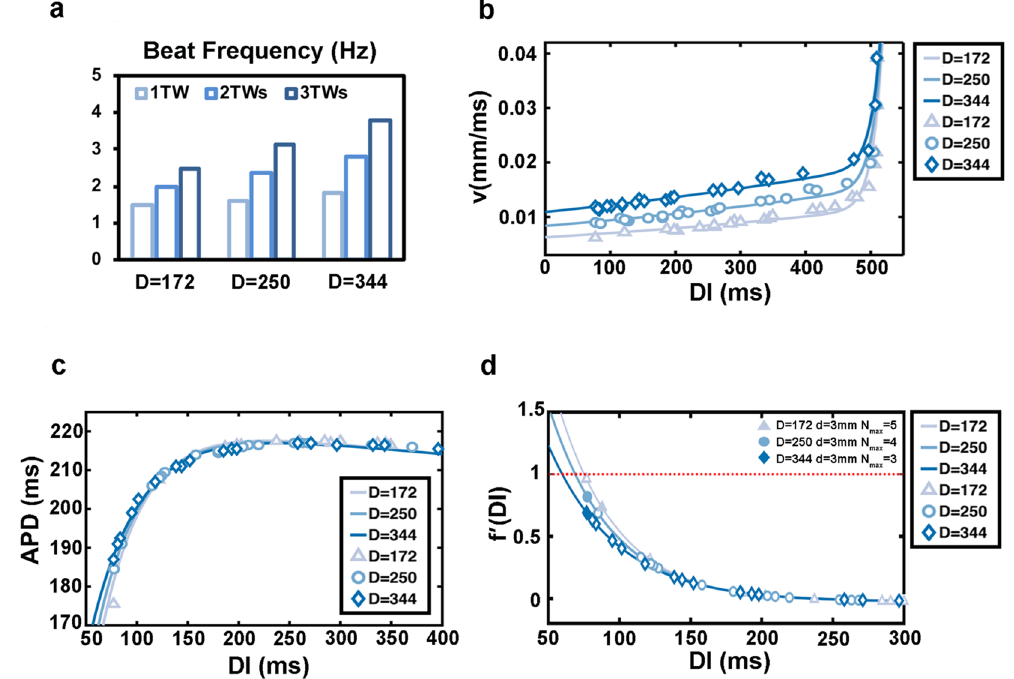
Figure 4. Increased strength of gap junctions leads to instability of traveling waves. ( a ) Beating frequency of cells in different numbers of traveling waves at three strengths of cell-cell coupling (d = 3 mm) (simulation). ( b – d ) The conduction velocity restitution curves ( b ), action potential restitution curves ( c ), and derivative of the action potential restitution function ( d ) with different gap-junction strengths. Triangle, circular and rhombus: simulation results; lines: fitting results.